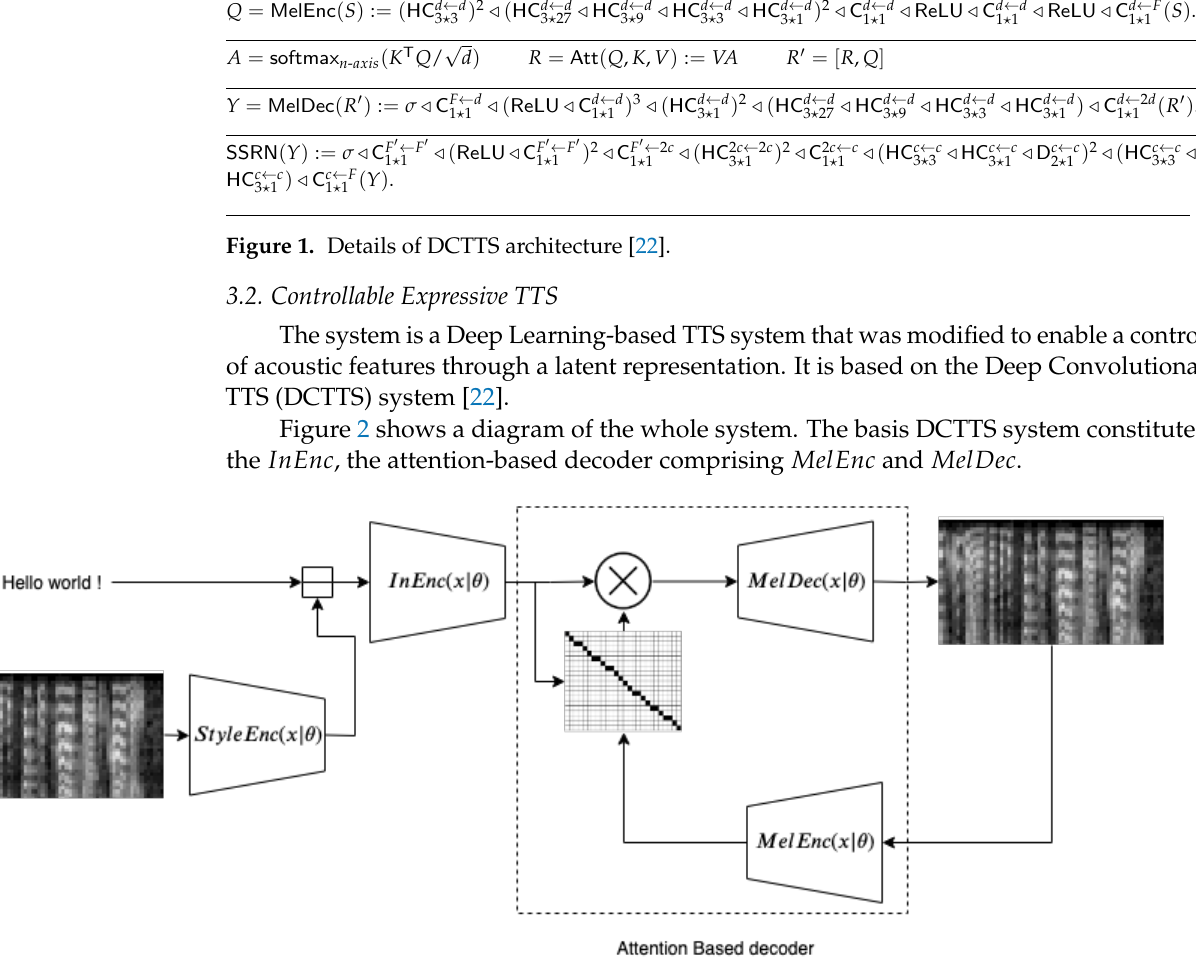
Figure 2. Block diagram of the system: During training, the mel-spectrogram is encoded by StyleEnc into a vector representing style. This vector is broadcast-concatenated to the character embeddings. The result is encoded by the InEnc network. Then an Attention-based decoder is used to generate the output